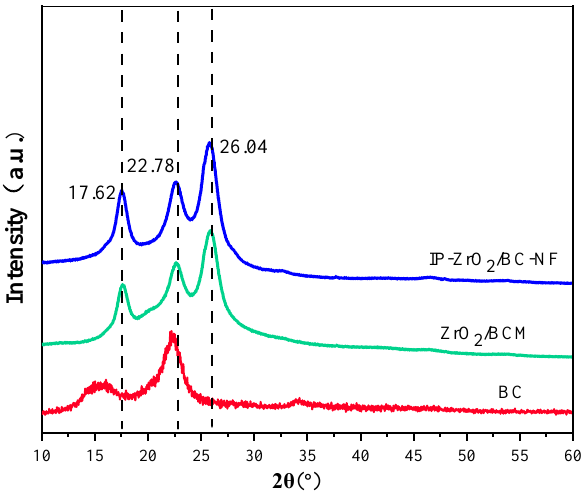
Figure 11. XRD of BCM, ZrO 2 /BCM, and IP − ZrO 2 /BC − NFM.